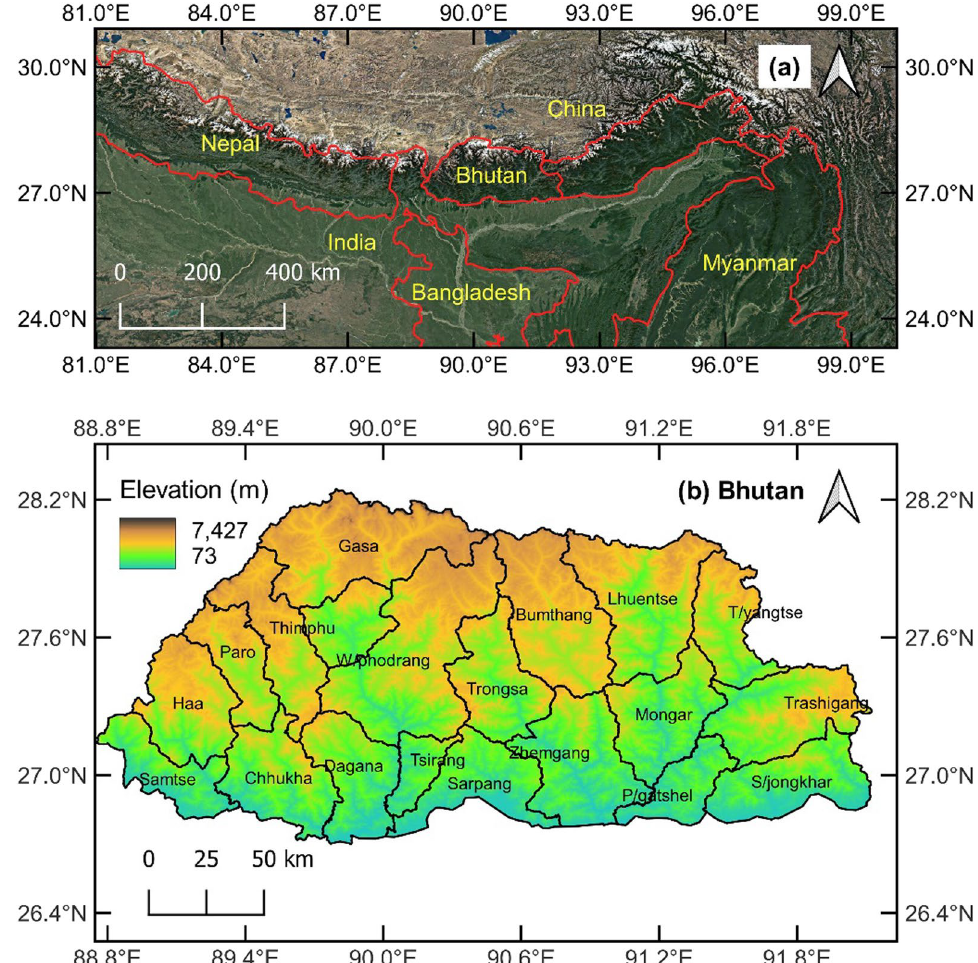
Fig. 1 Study area. a The geographical location of Bhutan, b district-level administrative units of